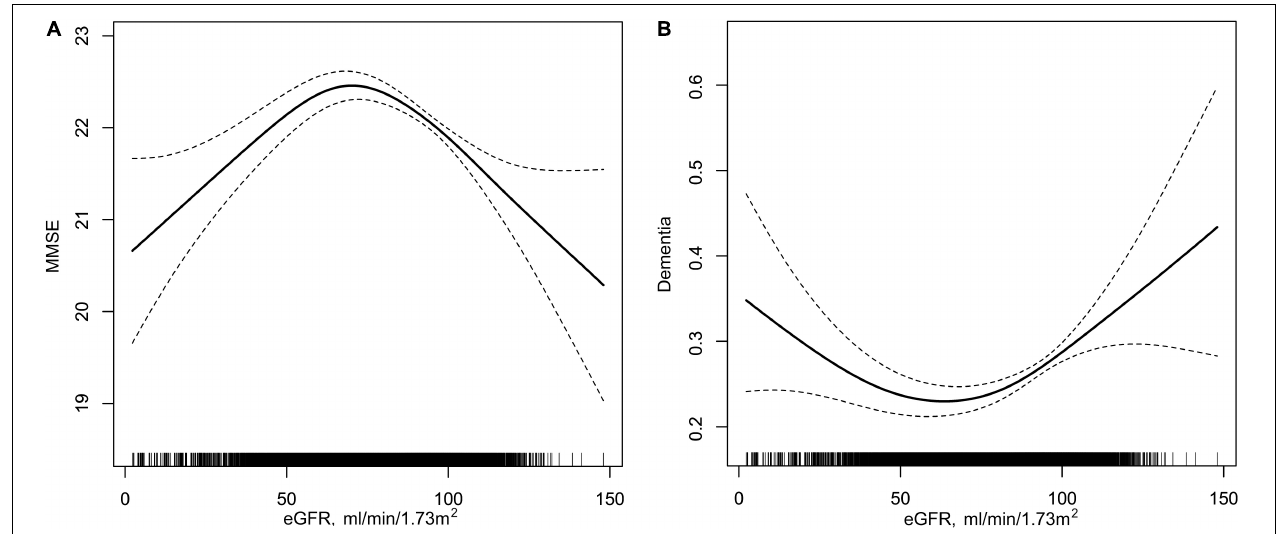
FIGURE 1 | Association of eGFR with MMSE and dementia in hypertensive population. (A) eGFR with MMSE; (B) eGFR with dementia. Solid lines in (A,B) represent β value and OR value, respectively; two dotted lines indicate 95% CIs. All analyses were adjusted for sex, age, body mass index, systolic blood pressure, diastolic blood pressure, education (except in B ), coronary heart disease, diabetes mellitus, smoking status, alcohol consumption, homocysteine, total cholesterol, triglycerides, high-density lipoprotein, and antihypertensive drugs. TABLE 2 | Threshold effect analyses of the relationship between eGFR and MMSE using two piecewise regression models. eGFR, ml/min/1.73 m